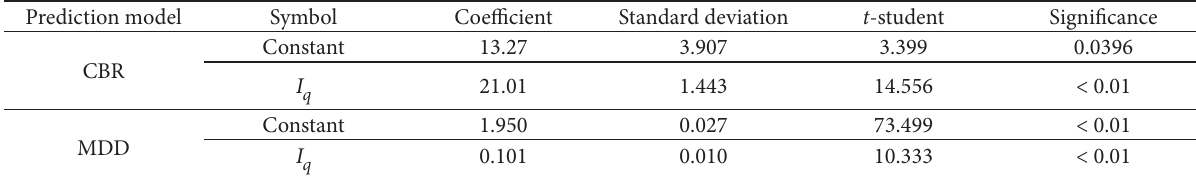
Table 4. The statistical value of the coefficients in the prediction CBR and MDD model Prediction